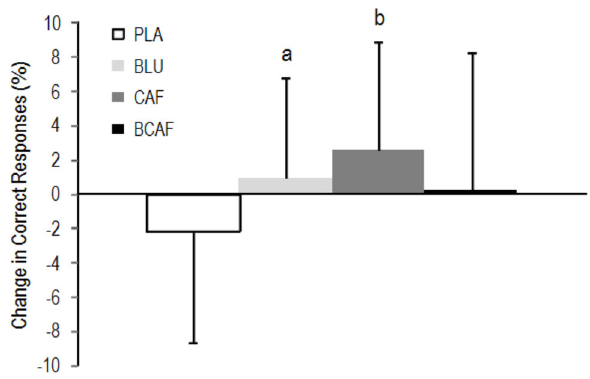
Figure 1. Change in the accuracy in the visual Go/No-Go psychomotor task. a: small difference from PLA, b: moderate difference from PLA. PLA: white light/placebo; CAF: white light/240 mg caffeine; BLU: blue light/placebo; BCAF: blue light/240 mg caffeine.